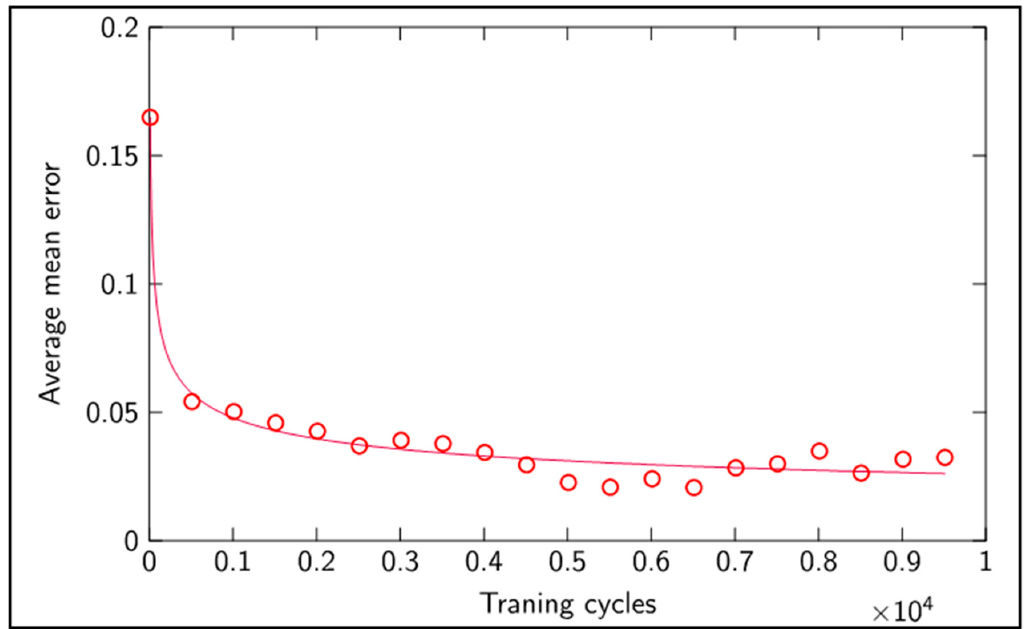
Figure 10. Average classification mean error versus number of training cycles.